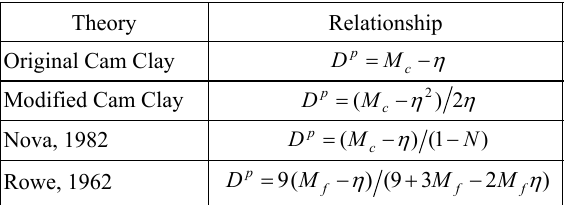
Table 1. Stress-dilatancy relationships